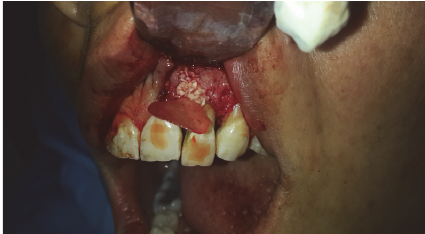
Figure 5: Guided tissue regeneration (GTR) was carried out using decalcifiedfreezedriedboneallograft(DFDBA)andabioabsorbable collagenous membrane.